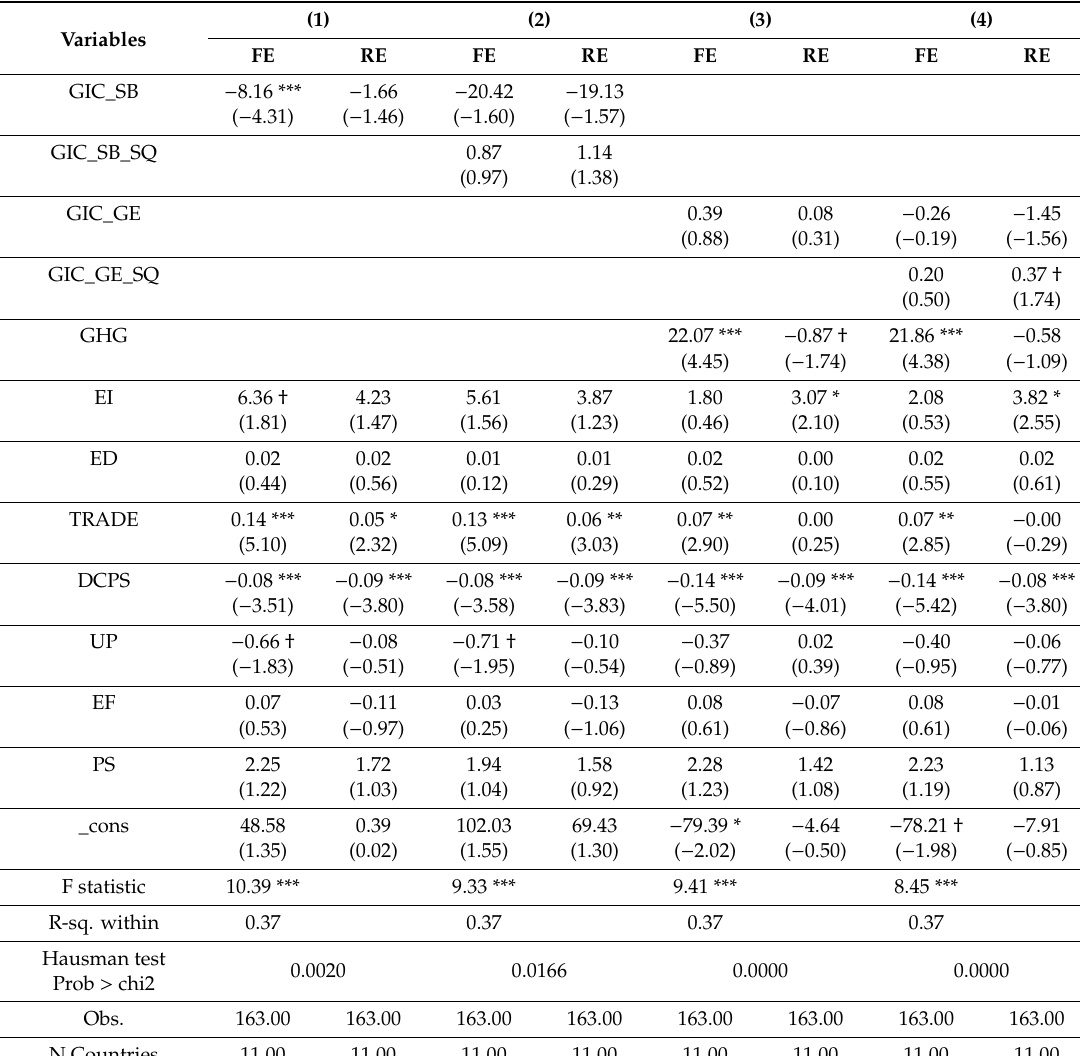
Table 7. Panel data regression models towards the influence of solid biofuels, excluding charcoal and geothermal energy on economic